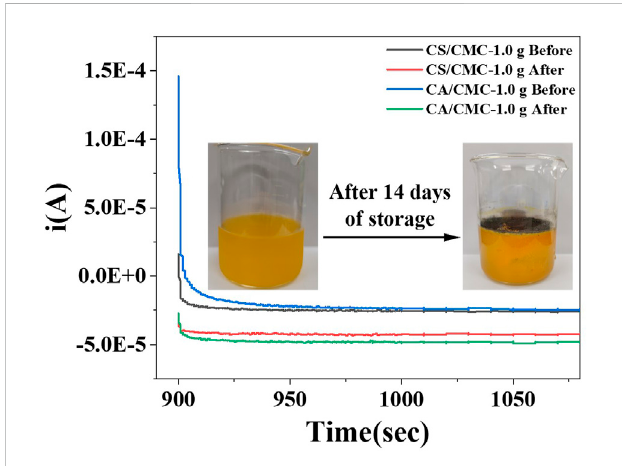
Steady current of the starch/CMC-1.0 composite fi